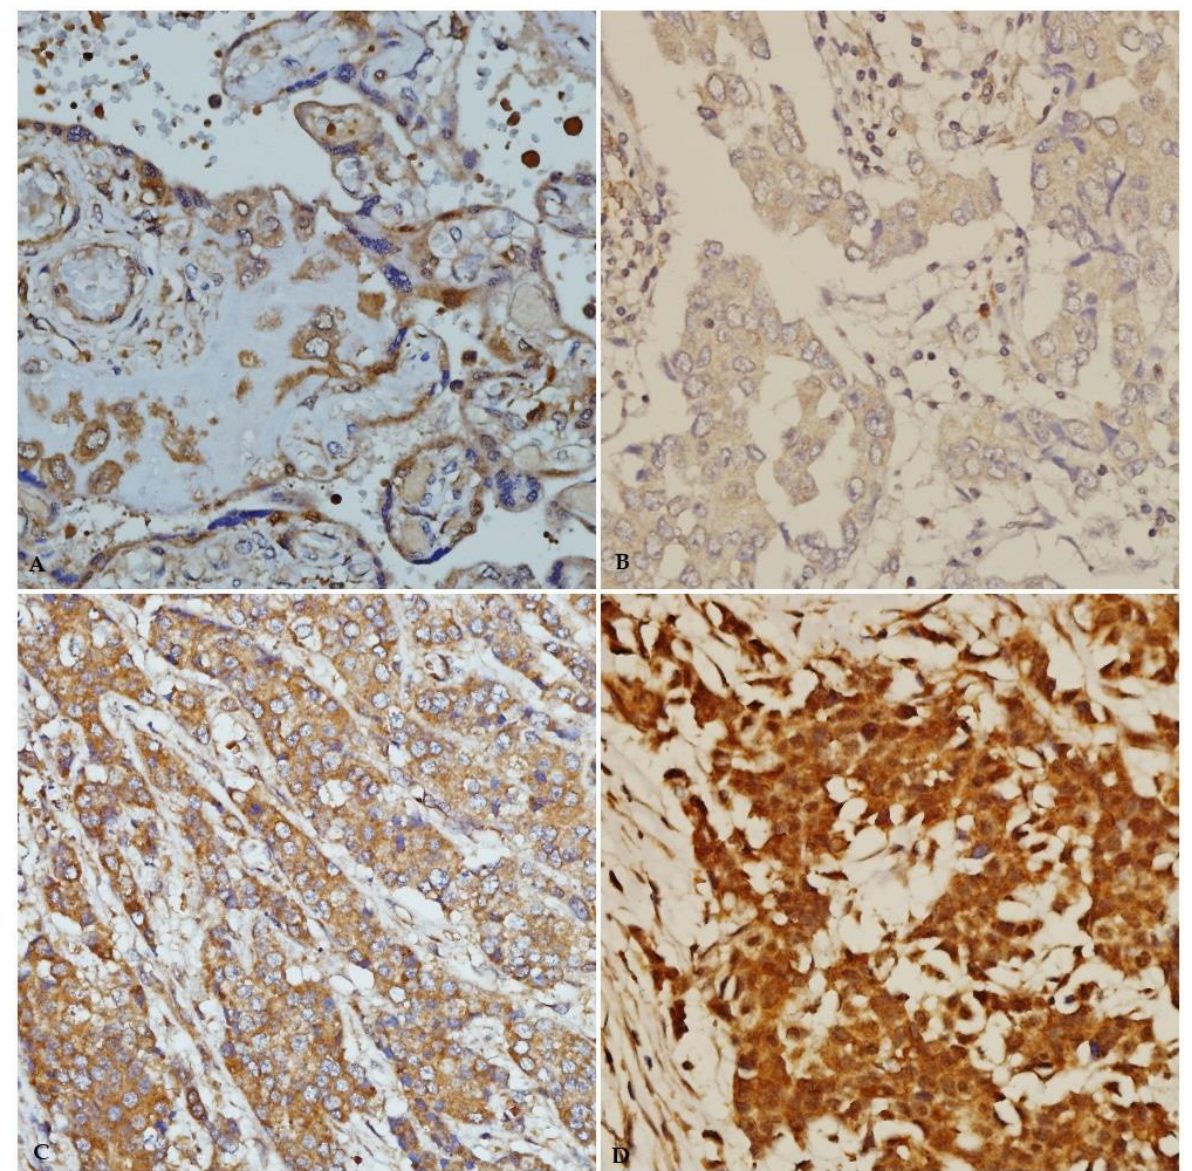
Figure 5. IGF-1 immunohistochemical staining in breast carcinoma tissue from young patients. ( A ) Immunostaining of positive-control placenta tissue (×40). ( B ) Weak IGF-1 immunostaining (×40). ( C ) Moderate IGF-1 immunostaining (×40). ( D ) Strong IGF-1 immunostaining (×40). 3.2. Associations of ANGPTL-4 and IGF-1 Expression with Breast Carcinoma Molecular